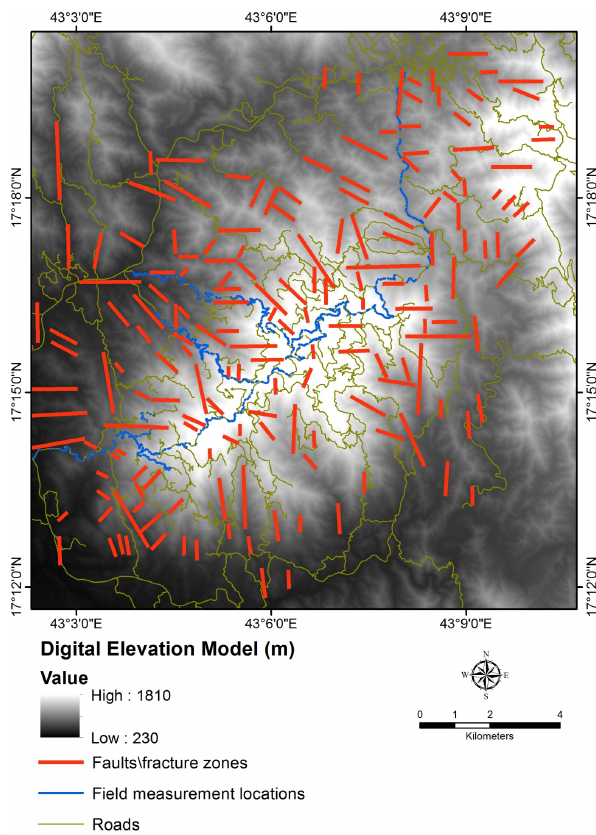
Figure 9. Distribution of the major zones of weakness (faults, fractures), sub-parallel and proximal fracture planes, and loca- tions where field measurements (fracture plane orientations) were